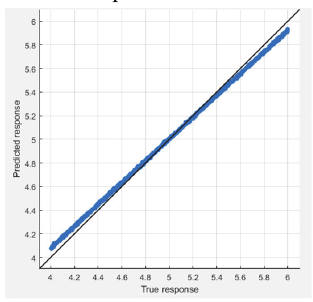
Fig. 13. Shortage prediction plot (yellow dot- record number and blue dot – response)